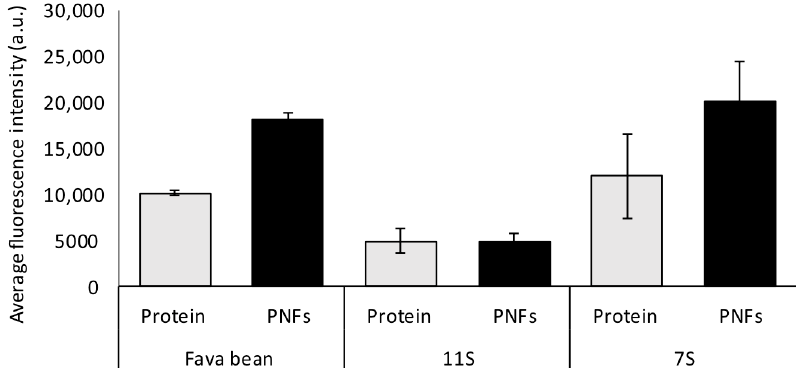
Figure 2. Average fluorescence intensity of non-fibrillated (protein) and fibrillated (protein nanofibrils, PNFs) samples from fava bean protein isolate and fava bean globular fractions 11S and 7S at pH 2 and concentration 10 mg/mL. The error bars refer to the standard deviation.